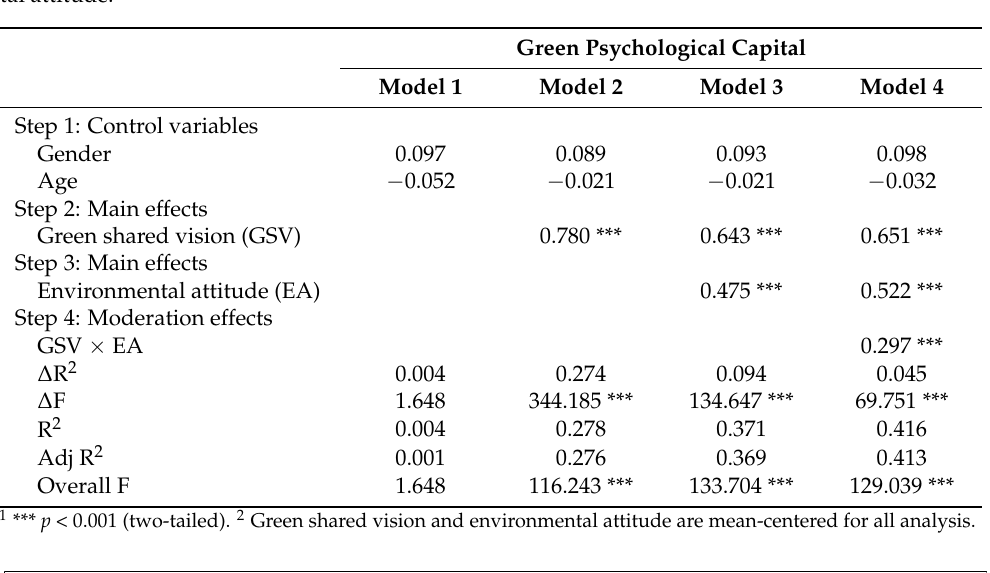
Table 6. Hierarchical regression results on green psychological capital moderated by environmen- tal attitude.